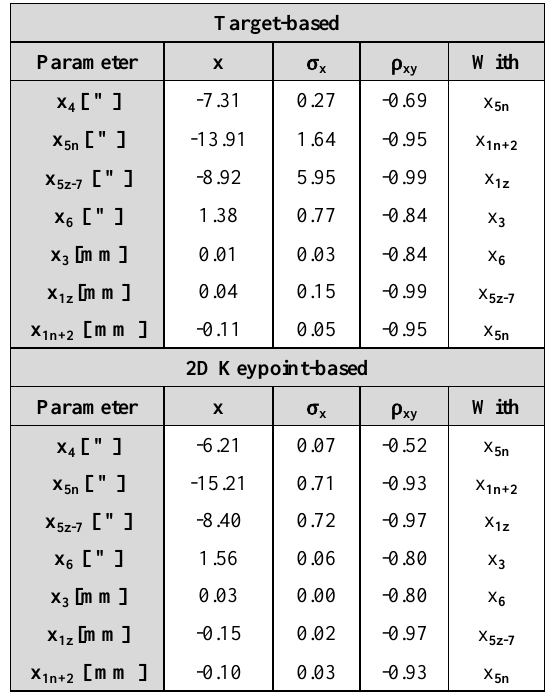
Table 3. The estimated calibration parameters, their standard deviations and maximal mutual correlations for the target-based and the 2D keypoint-based approach.